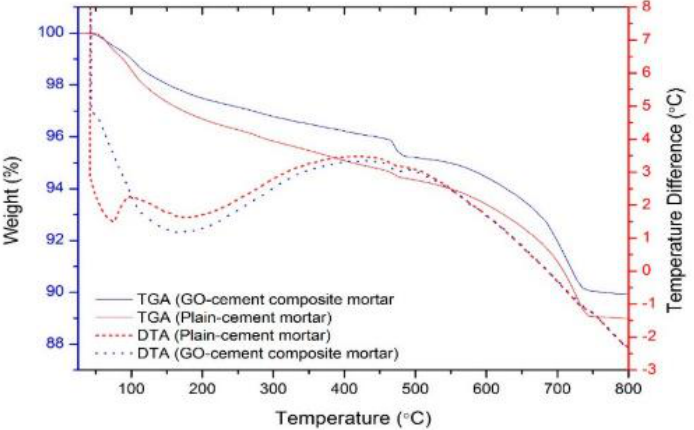
Figure 11. TGA/DTA curves of plain cement and GO/cement composites. Reprinted from Ref. [94].